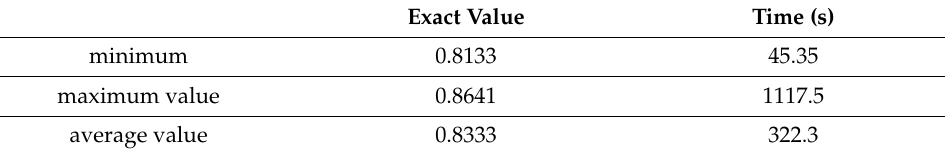
Table 6. DBN: X600 statistical results.